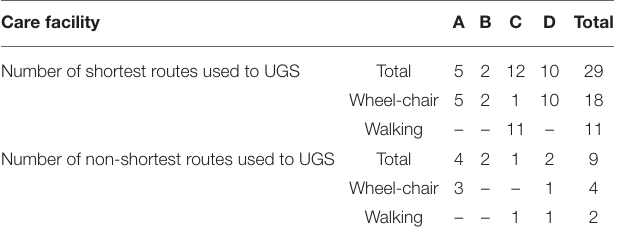
TABLE 4 | Shortest routes taken to urban green spaces (UGS).